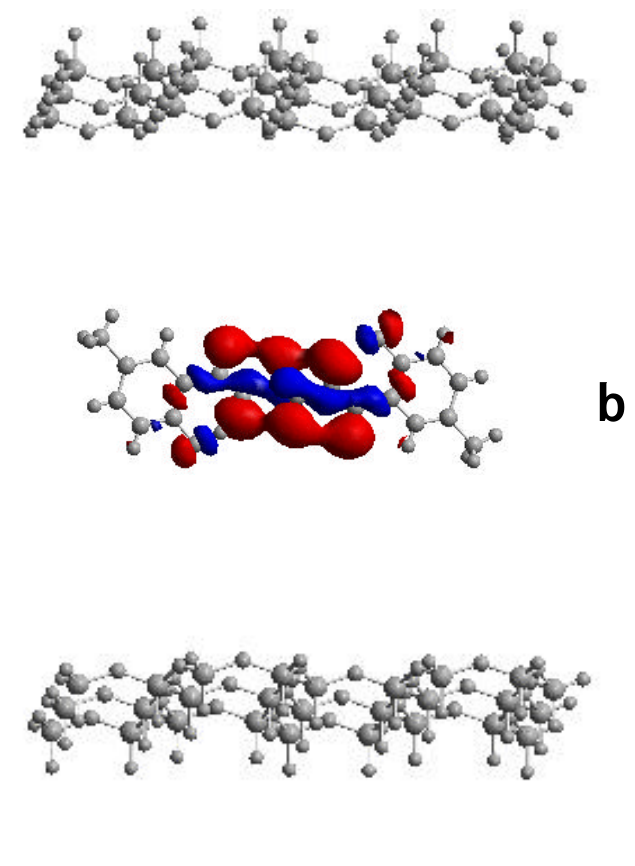
Figure 10: Plots of the HOMO orbitals of 3 in the gas phase (a) and upon confinement inside two mica sheets separated by 3.0 nm